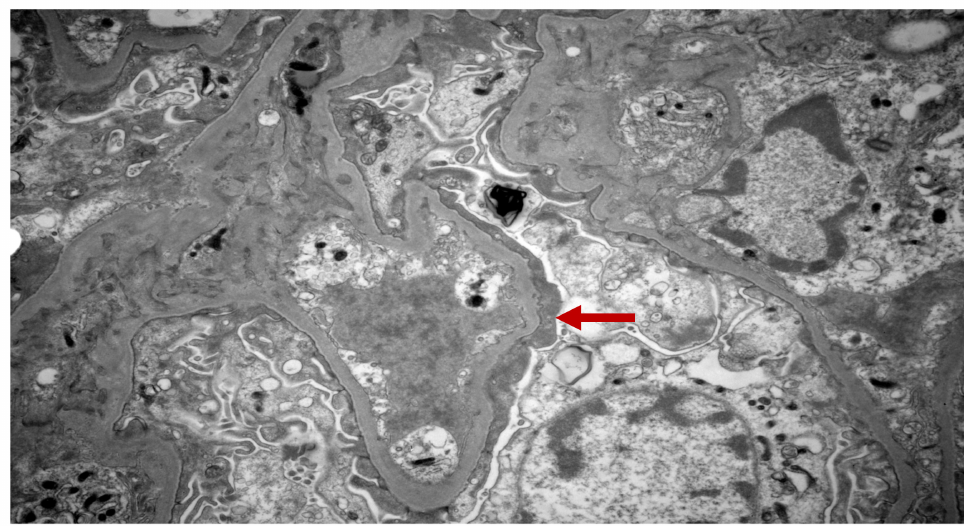
Figure 3. Renal biopsy. Electron microscopy showing absence of immune deposits or tubulo-reticular inclusions but presence of partial podocyte foot processes effacement (red